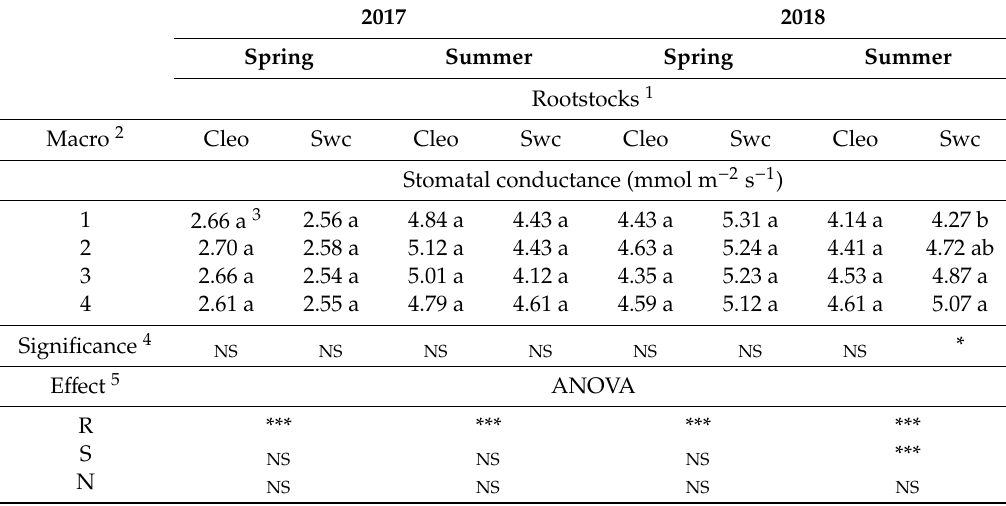
Table 2. E ff ect of rootstock and soil-applied plant essential nutrients on stomatal conductance of Huanglongbing (HLB)-a ff ected Hamlin citrus trees during the 2017–2018 seasons at Immokalee,